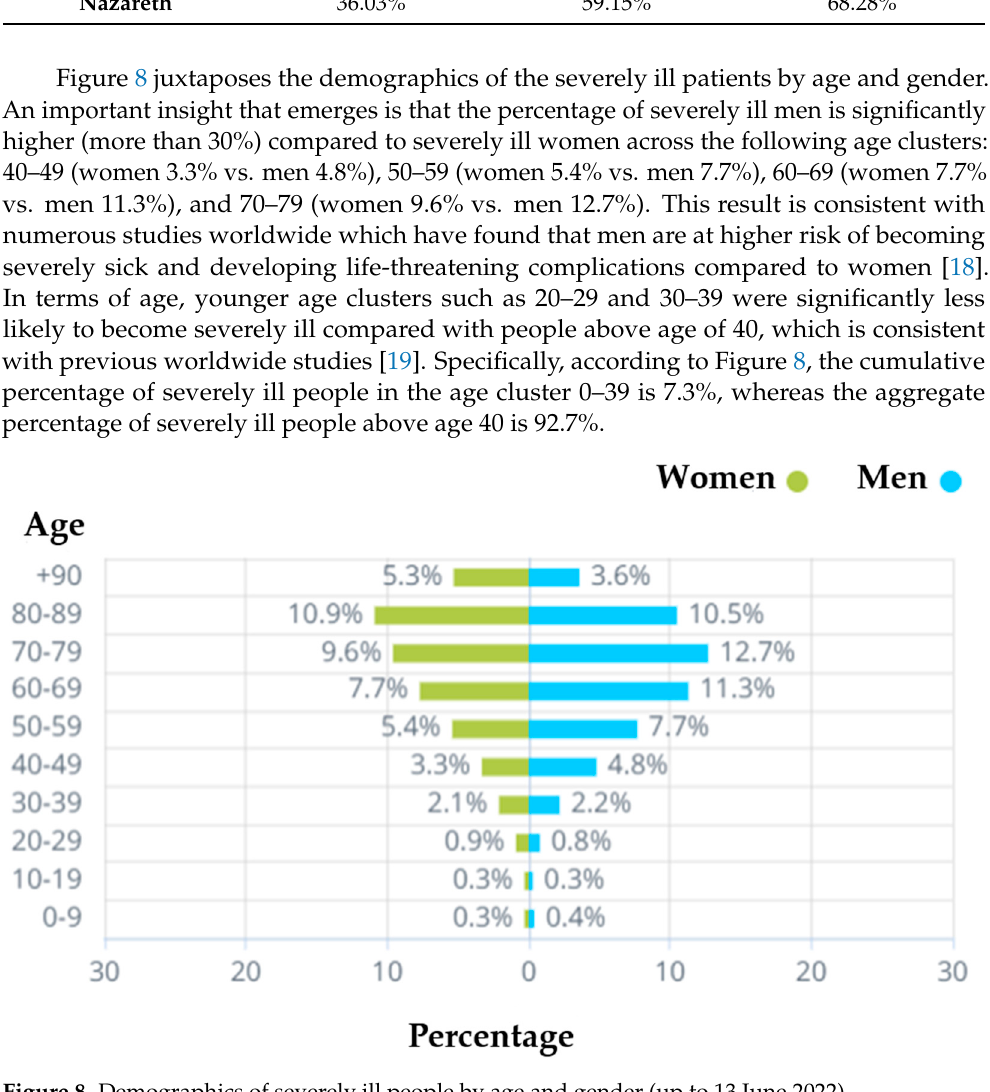
Figure 8 juxtaposes the demographics of the severely ill patients by age and gender.